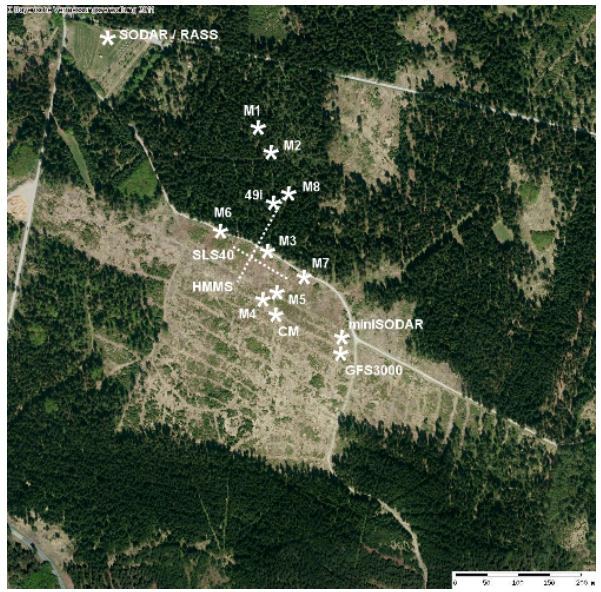
Figure 2. Top view of the investigation site of the EGER IOP3 project in summer 2011, with all measuring points and exact po- sitions of the main tower M1 (32m), the turbulence tower M2 (36m), the forest edge tower M3 (41m), the turbulence mast M4 (5.5m), the mast for the Modified Bowen-Ratio Method M5 (3.1m), the turbulence masts M6–M8 (5.5m), the mast for chemical measurements CM (2m), the Laser-Scintillometer SLS- 40, the Horizontal Mobile Measuring System HMMS, the ozone monitor “49i”, SODAR/RASS, miniSODAR, and the GFS3000 (leaf gas exchange measurements). The map is oriented to the north. Aerial image taken from Bayerische Vermessungsverwal- tung, URL: